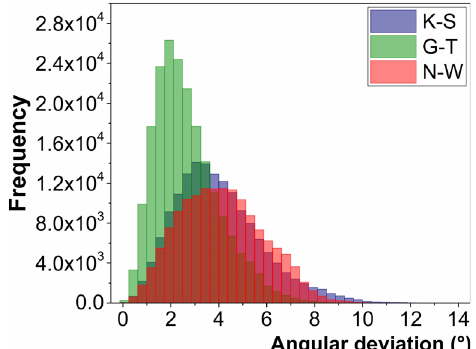
Figure 5. Sample after air-quenching treatment: angular deviation distributions between misorientations and the respective theoretical